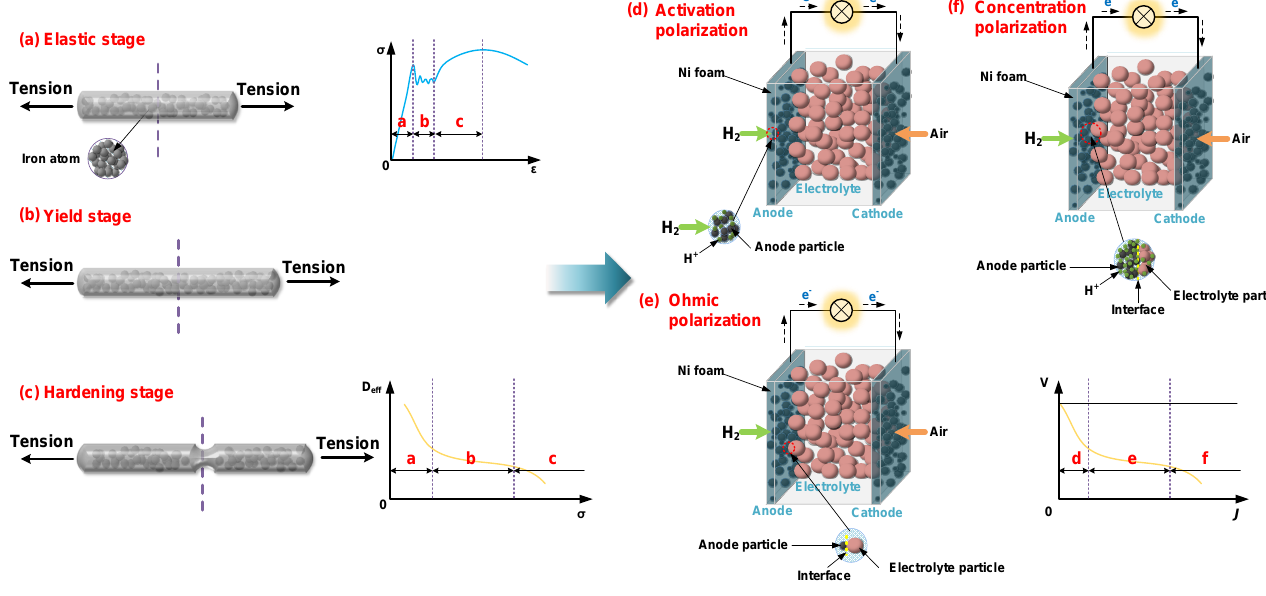
Figure 1. Stress–strain process of metal samples: ( a ) elastic stage, ( b ) yield stage, ( c ) hardening stage; polarization process of fuel cells: ( d ) activation polarization, ( e ) ohmic polarization, ( f ) concentration polarization.